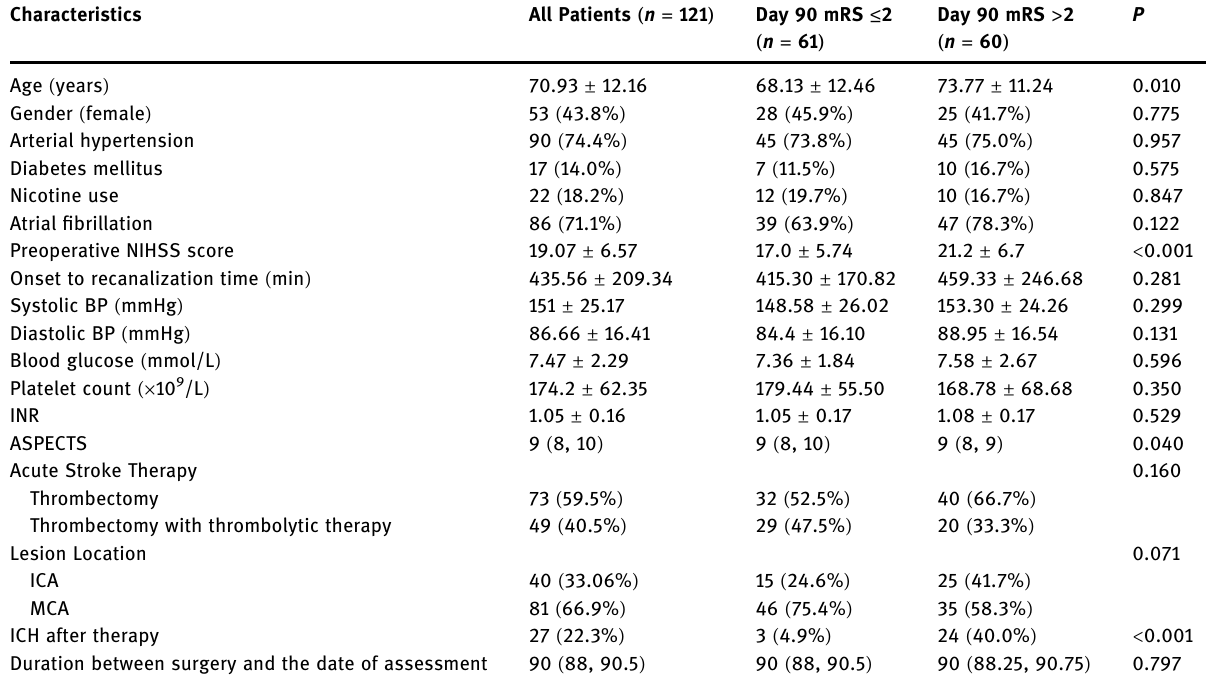
Table 1: Demographics, medical history, acute stroke therapy, and clinical/diagnostic fi ndings in patients with ischemic stroke successfully treated for anterior circulation vessel occlusion by mechanical thrombectomy Characteristics